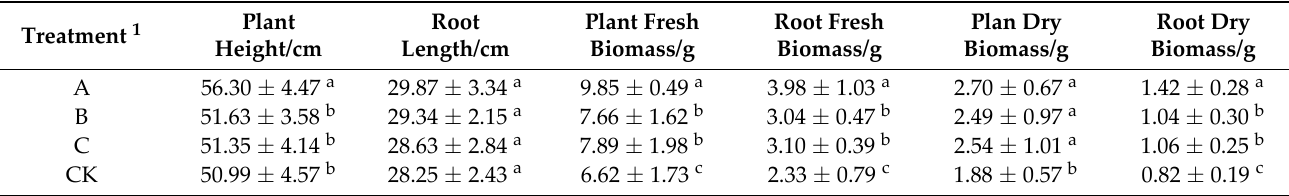
Table 5. Effects of MR‑16 on promoting the growth of S. divaricate